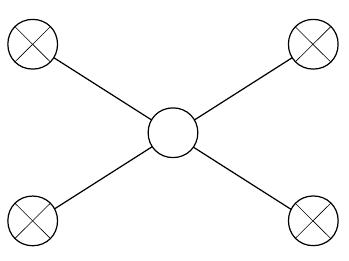
Figure 3 . The diagram associated to the TBA equations (5.45): the central node correspond to " 0 , the crossed nodes correspond to the fermionic pseudoenergies " (cid:6) n with n = 1 ; 3 and the lines represent the equations linking the pseudoenergies via the kernel (cid:30)